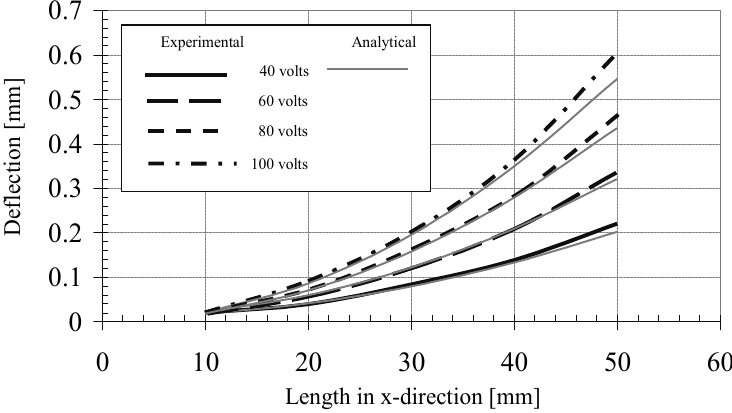
Figure 10. Experimental and analytical deflection of the bimorph according to different applied voltages.